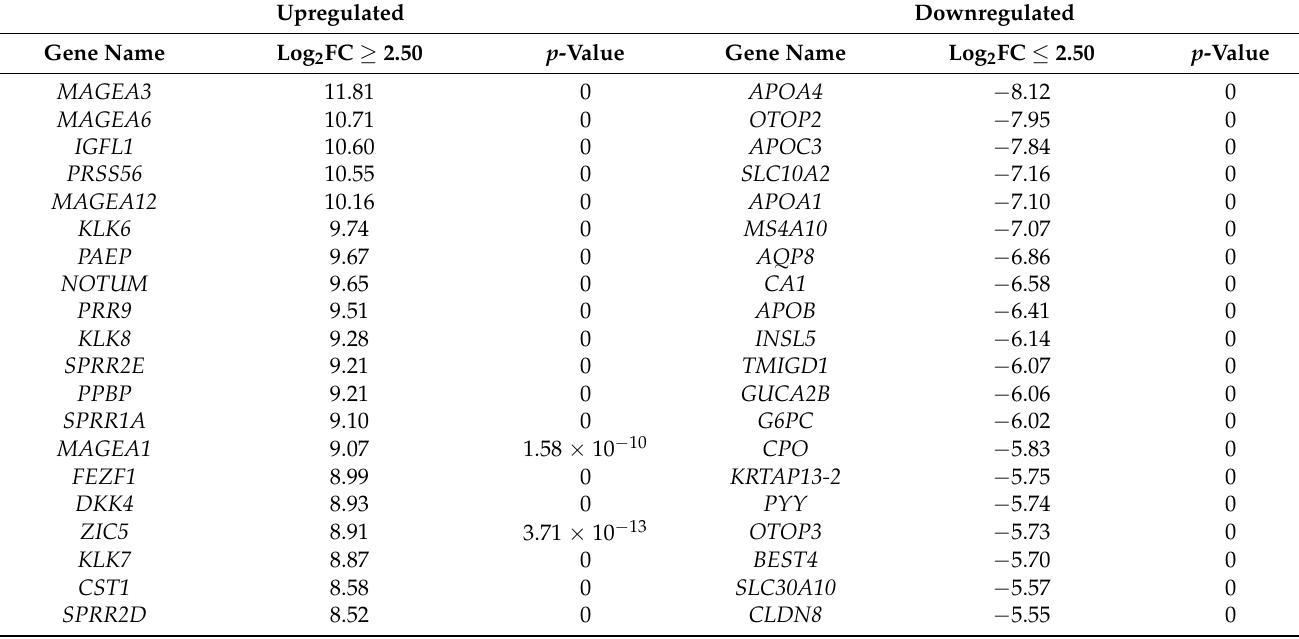
Table 1. Top 20 upregulated and downregulated DEGs in the colon cancer dataset TCGA-COAD. Upregulated